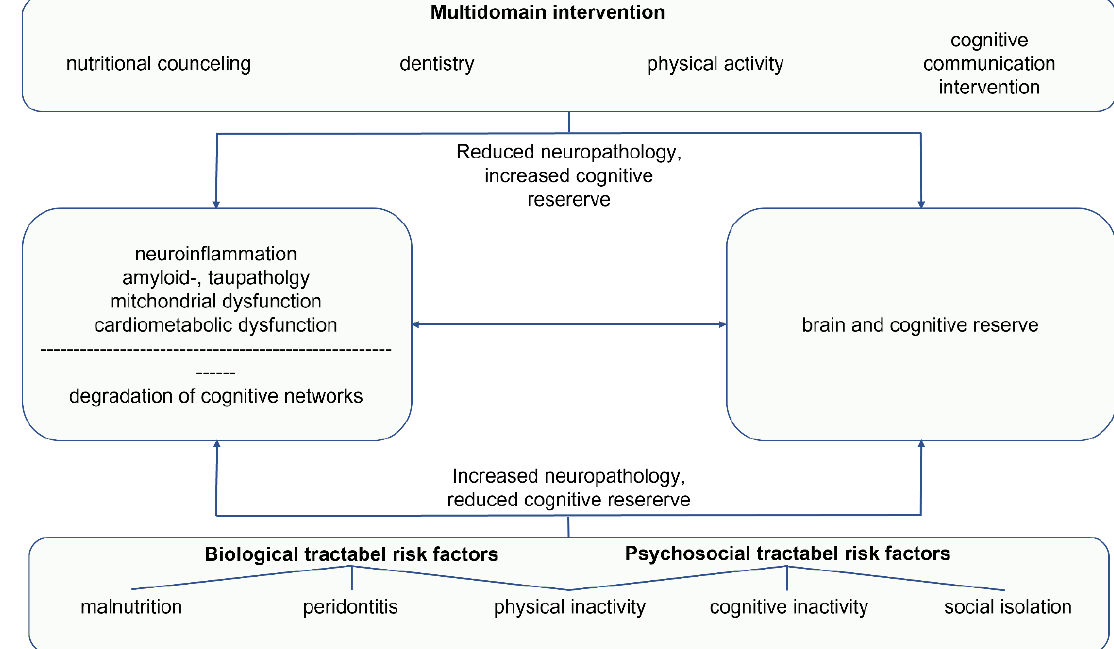
Figure 7. Association between biological and psychosocial tractable risk factors, intervention, neu- ropathology, and cognitive reserve.